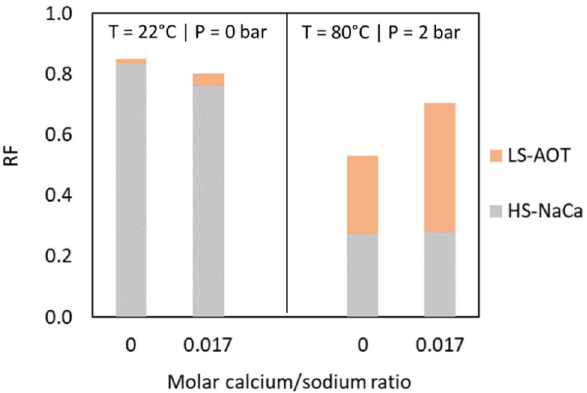
Figure 6. Average RF for crude oil C aged for 2 h and displaced first by HS-NaCa and then the different EOR fluids. Standard deviations for the measurements are within 10% error margin in all cases.